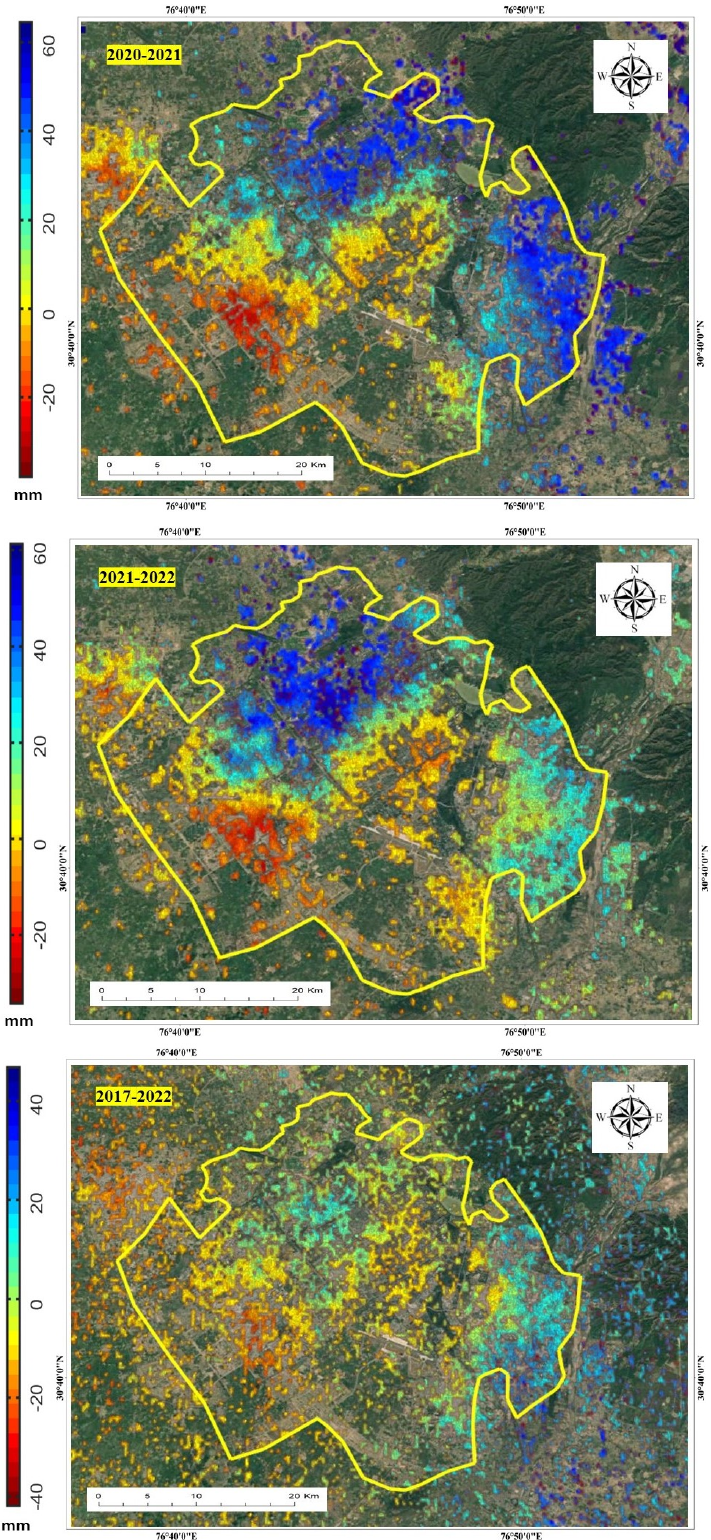
Figure 7. Google Earth overlays of urban surface subsidence maps from 2017 to 2022 in different time frames.